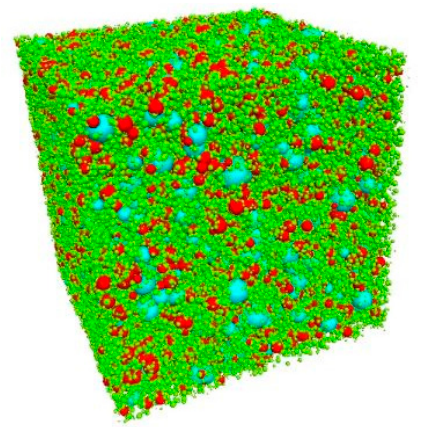
Figure 1. Discrete Element model of a 150 mm edge length concrete cube. Each color marks a different fraction (green: 0/4; red: 4/8; cyan: